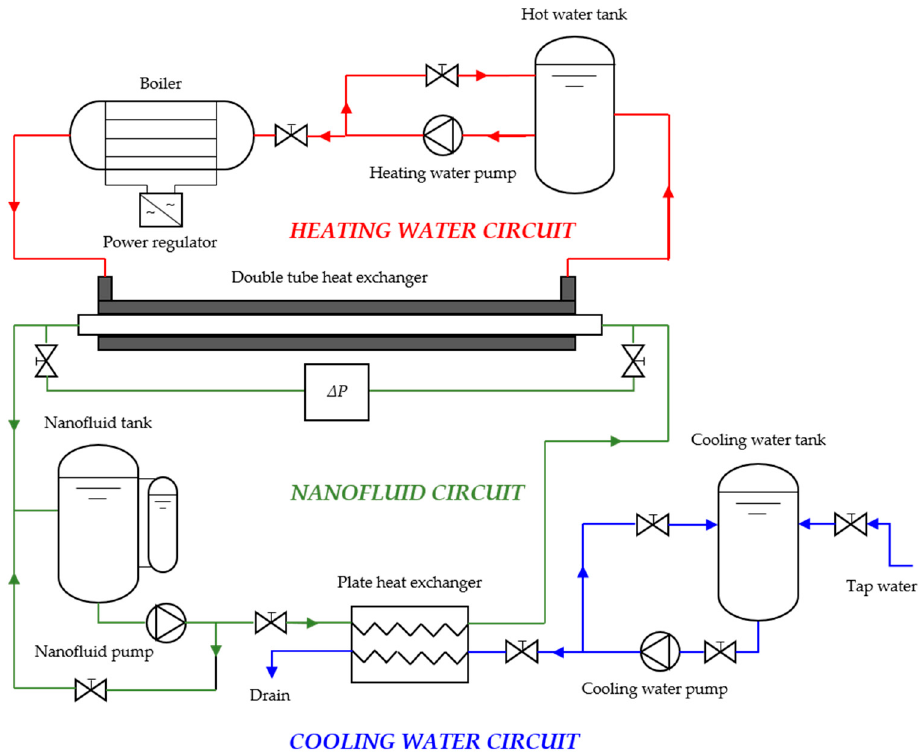
Figure 2. Scheme of the experimental test rig used to obtain convective heat transfer coefficients and pressure drops.